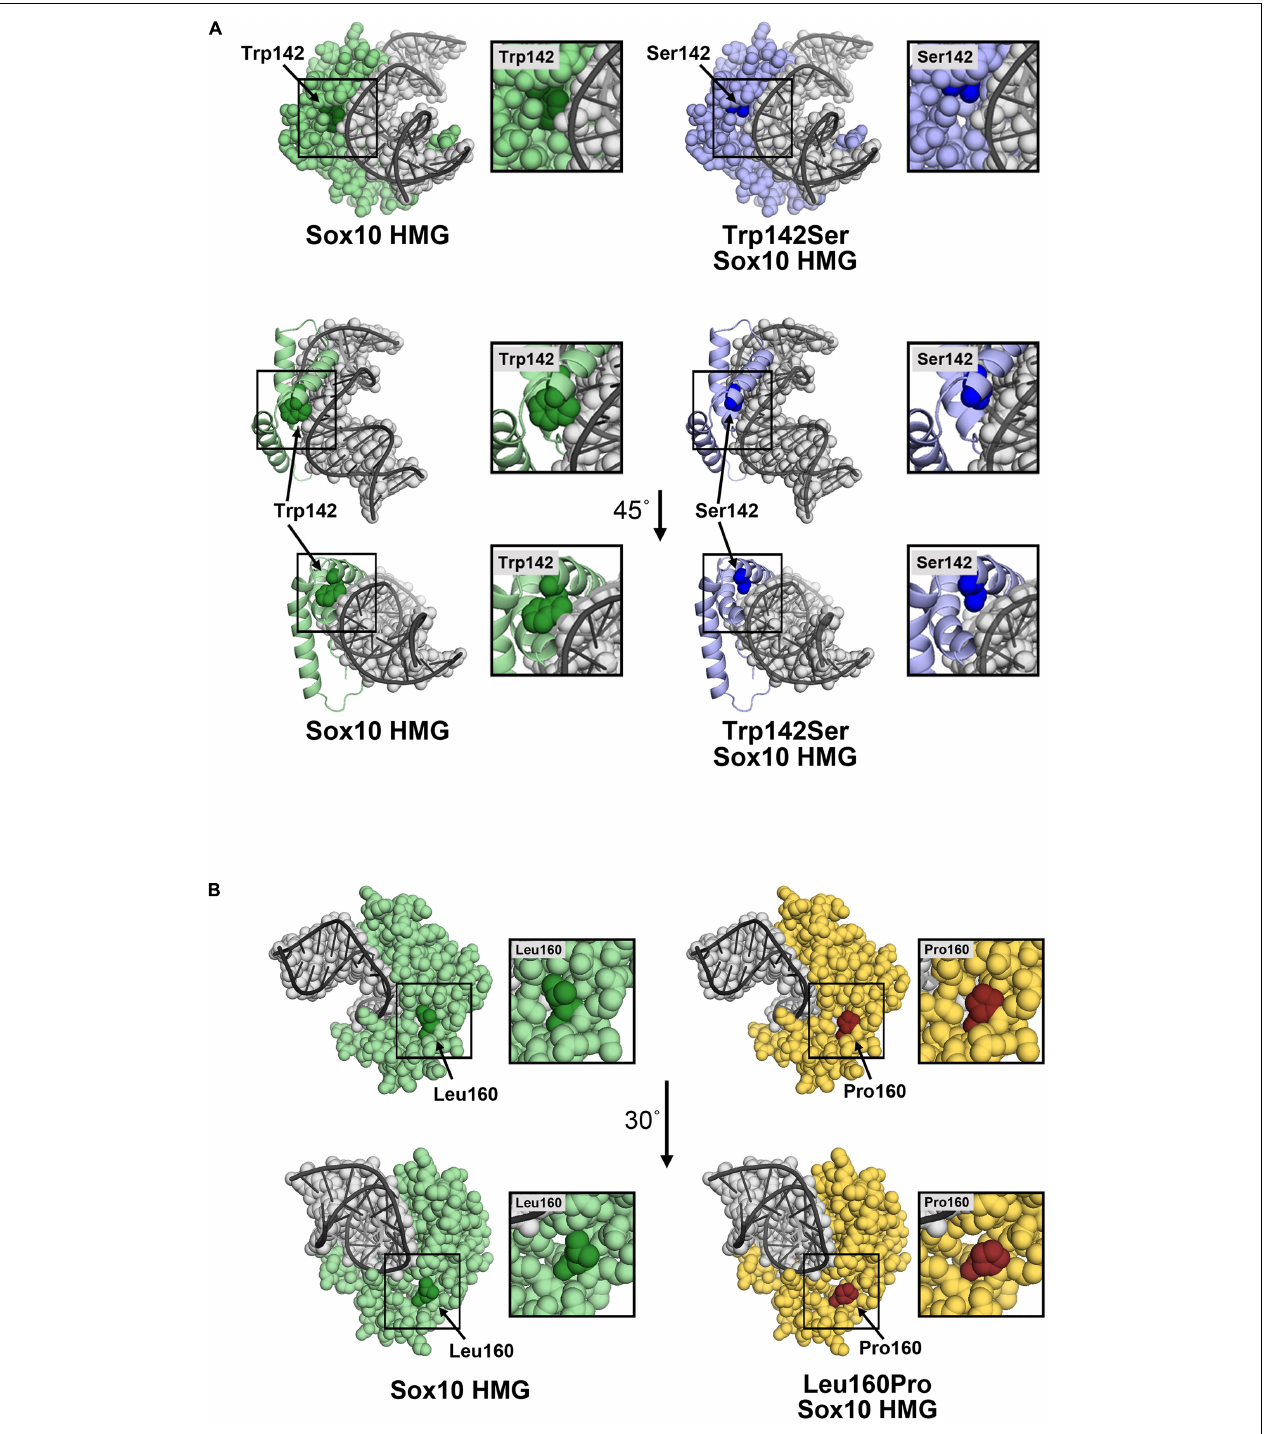
FIGURE 6 | Molecular models of p.Trp142Ser and p.Leu160Pro. (A) Model of the SOX10 HMG domain showing Trp142 and Ser142 substitution. The SOX10 HMG domain generated using Swiss-Model is presented as a space-filling model (upper panel) or ribbon diagram (lower panel) with only residue 142 with space-filling representation. Wild-type Trp142 is shown in dark green and other residues in light green. The Trp142Ser substitution is shown in dark blue and other residues in light blue. The DNA strand (gray) is shown as an overlay of the space-filling and ribbon formats. Contacts between Trp142 and DNA were noted. Substitution of Trp142 with Ser eliminated contact between residue 142 and the DNA chain. (B) Model of SOX10 HMG domain showing Leu160 and the Pro160 substitutions. The SOX10 HMG domain generated using Swiss-Model is presented as a space-filling model. Wild-type Leu160 is shown in dark green and other residues in light green (left panel). The Leu160Pro substitution is shown in red and other residues in yellow (right panel). Residue 160 does not make direct contact with the DNA chain.